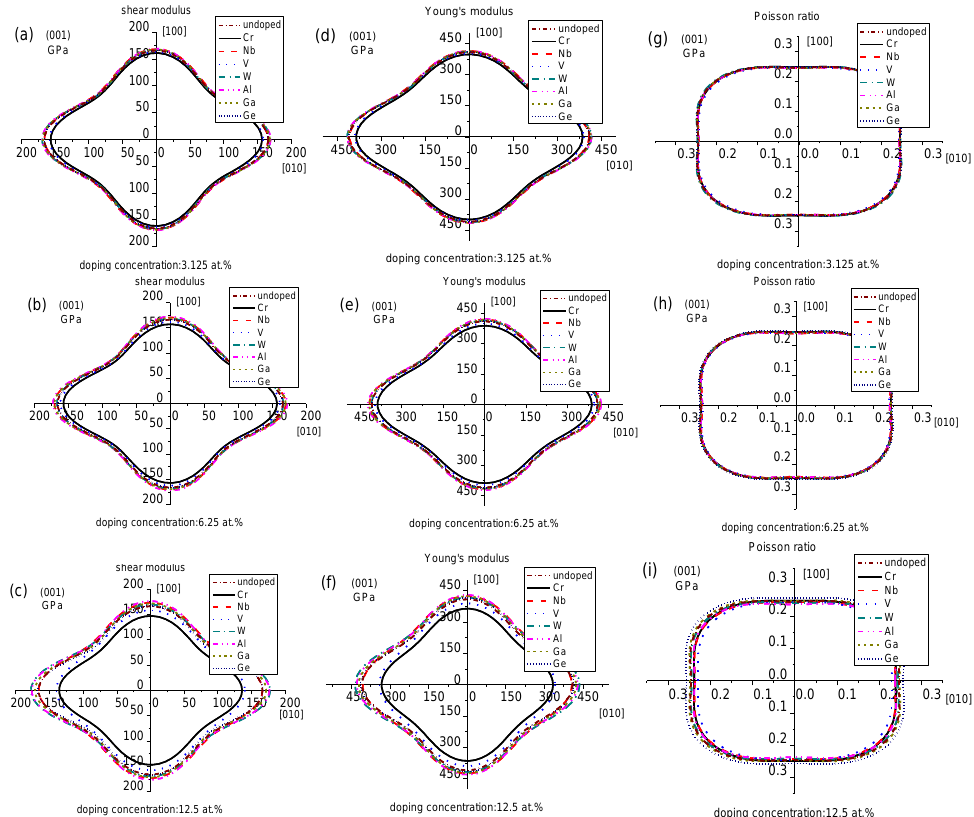
doping concentration:12.5 at.% Figure 7. Two-dimensional projections of the shear modulus, Young’s modulus and Poisson ratio for undoped and doped Mo 3 Si. ( a – c ) Shear modulus; ( d – f ) Young’s modulus; ( g – i ) Poisson ratio.